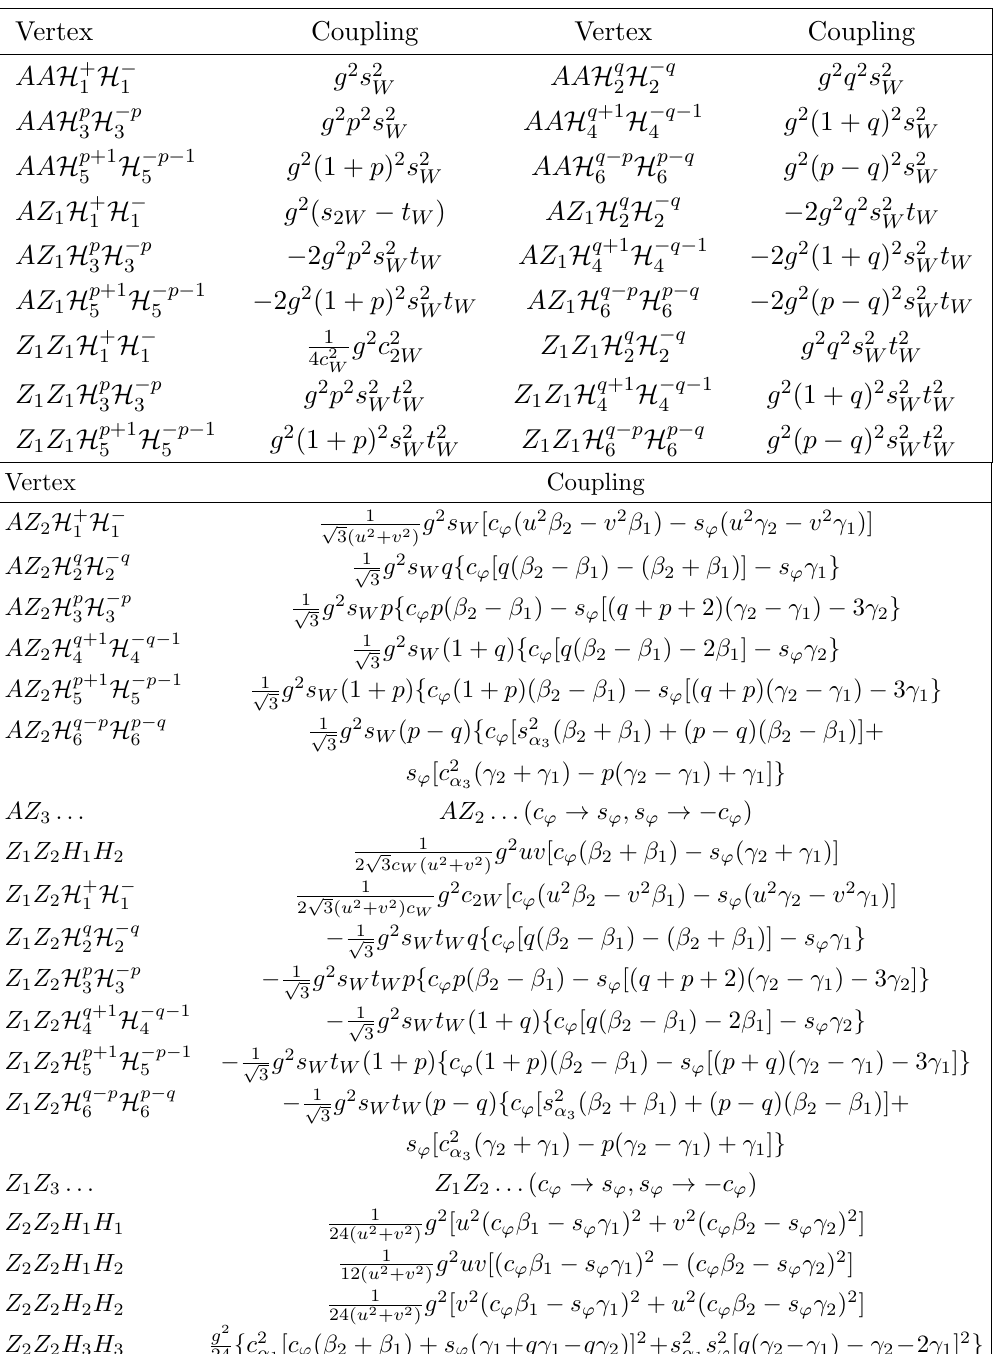
Table 17 . The interactions of two neutral gauge bosons with two scalars (table Continued).